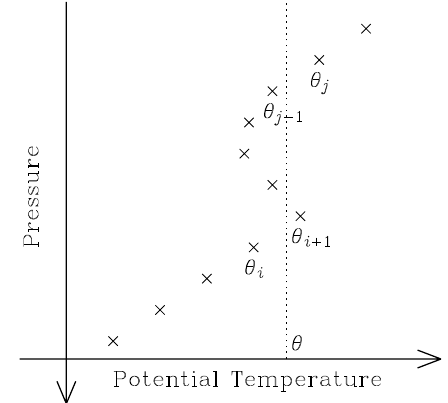
Fig. A1. Schematic illustration of interpolation to an isentropic sur- face θ located in an inversion layer encountered by radiosonde ob- Fig. 15. Schematic illustration of interpolation to an isentropic surface θ located in an inversion layer encoun- servations (crosses). Linear interpolation will be made by using data tered by radiosonde observations (crosses). Linear interpolation will be made by using data pairs with θ i and pairs with θ i and θ j in this θ j in this case.